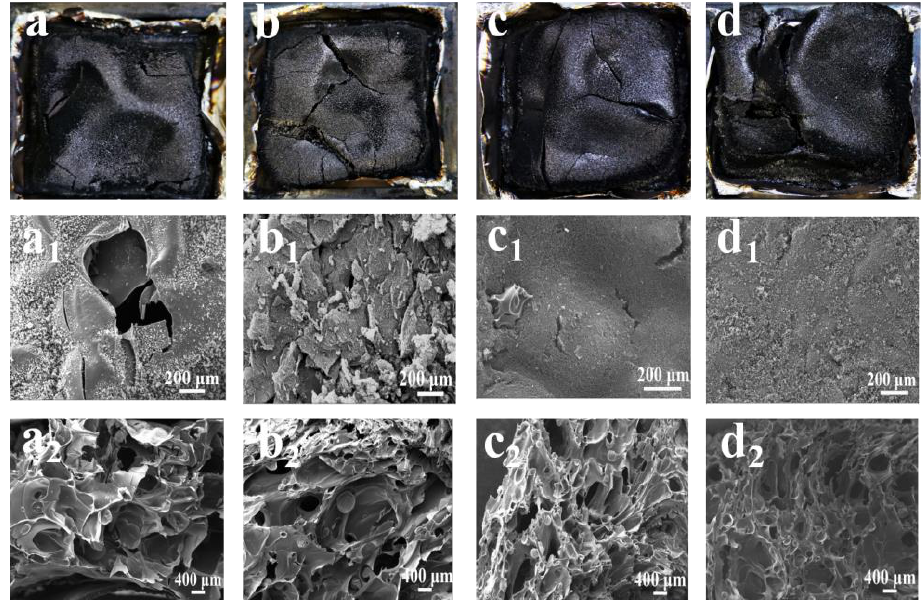
Figure 8. Digital photos of the charred layers ( a – d ) and SEM images of the carbon residues outside regions ( a 1 – d 1 ) and internal structures ( a 2 − d 2 ) of ( a ) PBa, ( b ) PBa/PD-fu-1%, ( c ) PBa/PD-fu-3% and ( d ) PBa/PD-fu-5%.